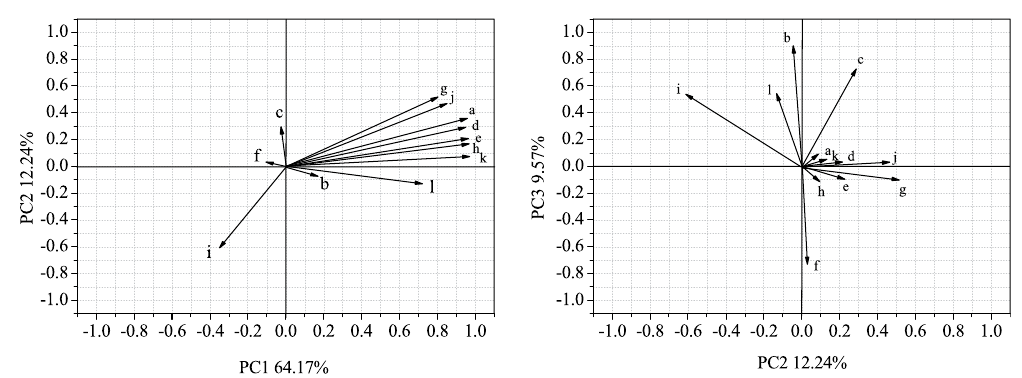
Figure 4. Principal component analysis of soil respiration as explained by carbon and nitrogen storage. a-soil organic carbon storage in the 0–10 cm soil layer, b-soil organic carbon storage in the 10–20 cm soil layer, c-soil organic carbon storage in the 20–30 cm soil layer, d-soil nitrogen storage in the 0–10 cm soil layer, e-soil nitrogen storage in the 10–20 cm soil layer, f-soil nitrogen storage in the 20–30 cm soil layer, g-plants carbon storage, h-root carbon storage in 0–30 cm soil layer, i-litter carbon storage, j-plants nitrogen storage, k-root nitrogen storage in 0–30 cm soil layer, l-litter nitrogen